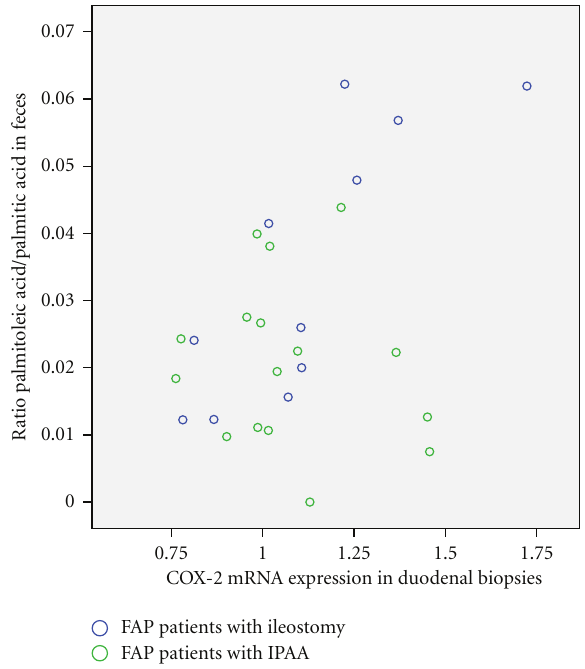
Figure 1: The scatterplot shows the ratios of palmitoleic acid/palmitic acid in feces samples and the levels of cycooxygenase-2 expression in duodenal biopsies (ileostomy group, n = 12: r = 0 . 8, P = . 003; ileal-pouch-anal anastomosis group, n = 16: r = − 0 . 2, P = .